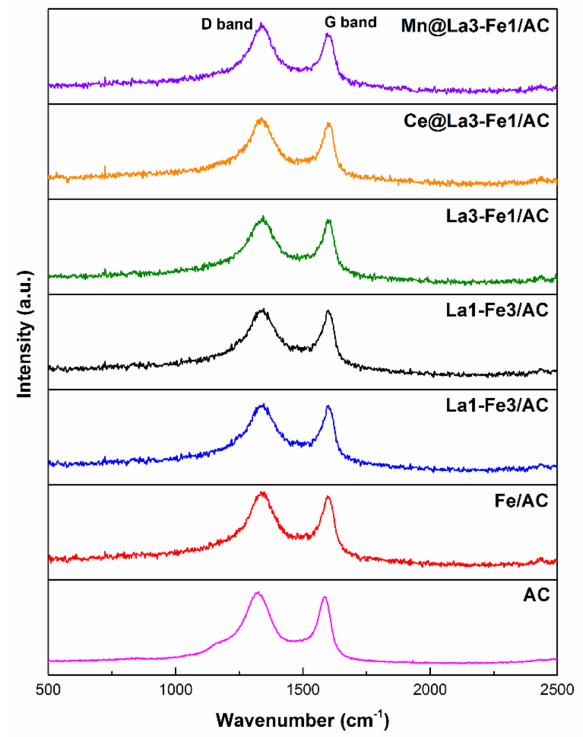
Figure 1. Raman spectroscopy of the synthesized